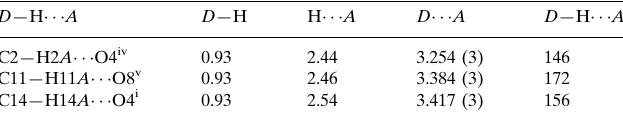
Hydrogen-bond geometry (A˚ , (cid:2)